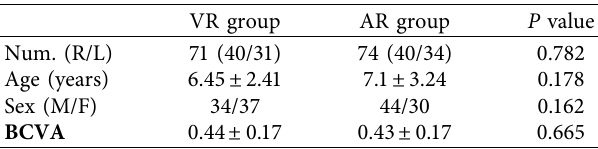
Figure 1: The exhibition of visual perceptual training. (a) The apparatus of VR. (b) The view of Game 1 for VR. (c) The view of Game 2 for VR. (d) The apparatus of AR. (e) The view of Game 1 for AR. (f) The view of Game 2 for AR. Table 1: Participant